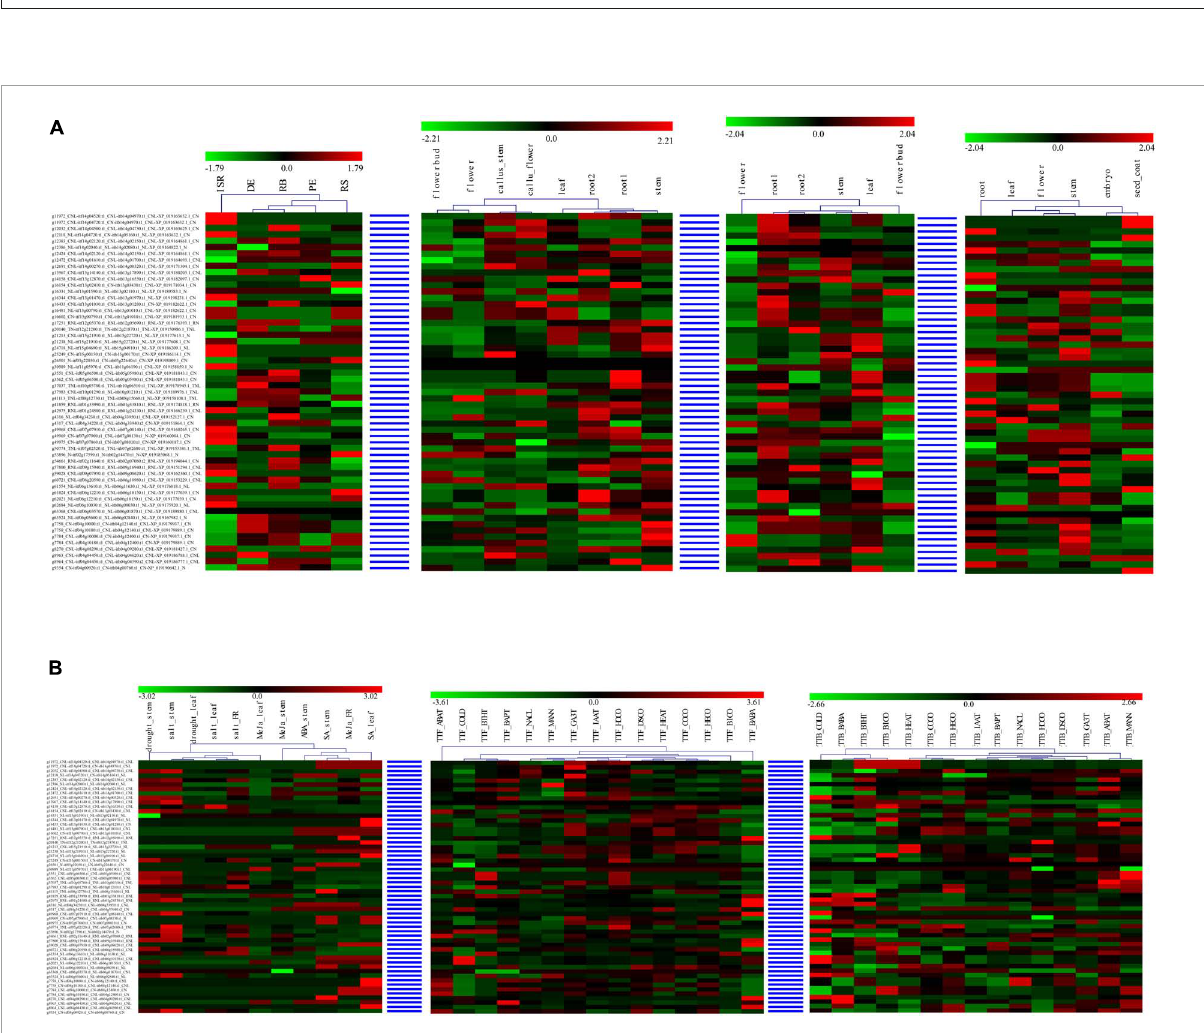
FIGURE7 Heatmap of compared expression profiles of syntenic nucleotide-binding site (NBS)-encoding genes in the four Ipomoea species. The heatmap of syntenic NBS-encoding gene set was named as “sweet potato gene-” + “ I. trifida gene-” + “ I. triloba gene-” + “ I. nil gene.” (A) Heatmap of compared expression profiles of syntenic NBS-encoding genes in the four Ipomoea species tissues. (B) Heatmap of compared expression profiles of syntenic NBS-encoding genes in the four Ipomoea species in response to